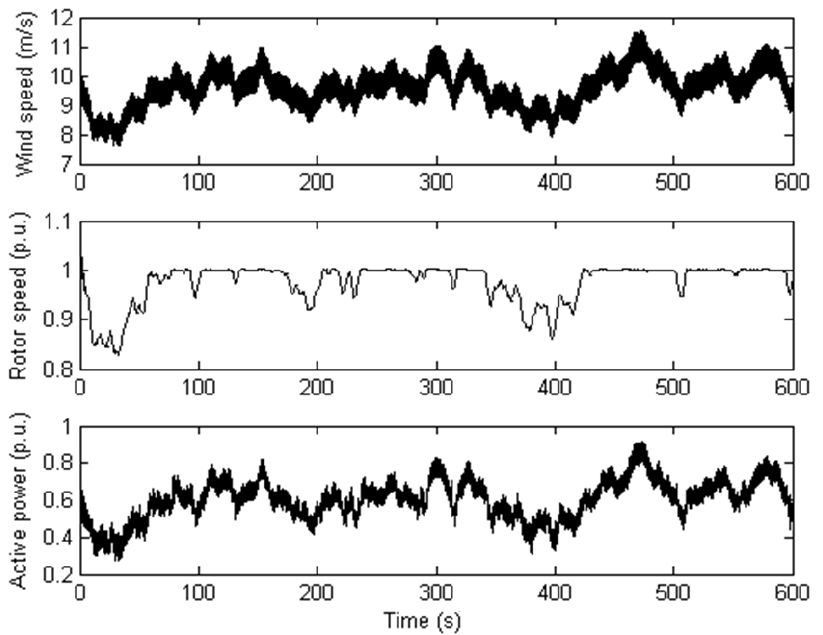
the wind turbine.